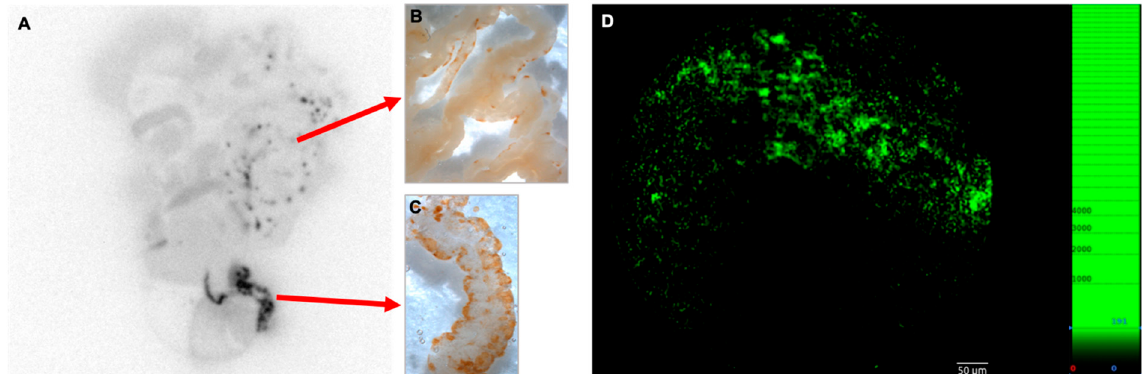
Figure 2. Multimodal correlated images of preferential sites during early lymphoma spreading. Correlation of ex vivo autoradiographic image of the abdominal organs ( A ) in a mouse 24 h after intraperitoneal inoculation of 5 × 10 6 tumor cells (pre-loaded with CFSE dye) with anti-FITC immunodetection (visualized as brown DAB precipitate) of lymphoma cells, which demonstrates a matching pattern in the mesentery (M) and the omentum (Om; B , C ). The diagnostic radiotracer 18 F-FDG molecule was injected intraperitoneally 2 h before imaging (n = 9). Direct fluorescence visualization of fluorescein ex vivo using fluorescence confocal fiberoptic microscopy of the omentum revealed small- to medium-sized cell clusters ( D ).